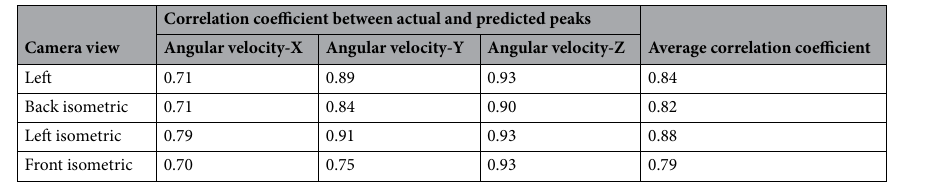
Table 3. Correlation coefficients for different camera